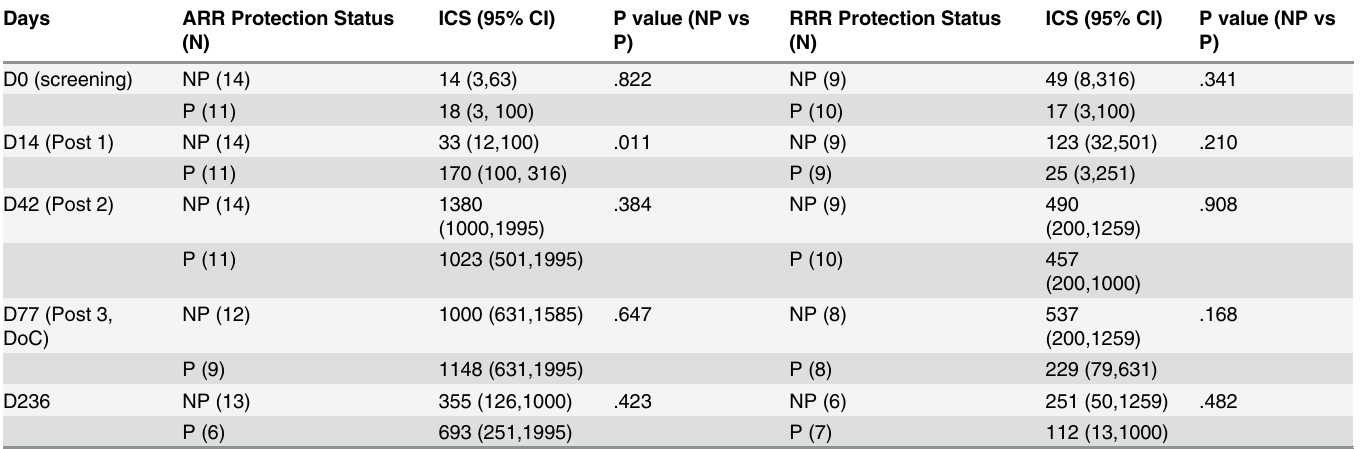
Table 3. Frequency of CS-specific CD4+ T cells expressing at least 2 cytokines/activation markers per million PBMC, by treatment group and pro- tection status (ATP cohort for